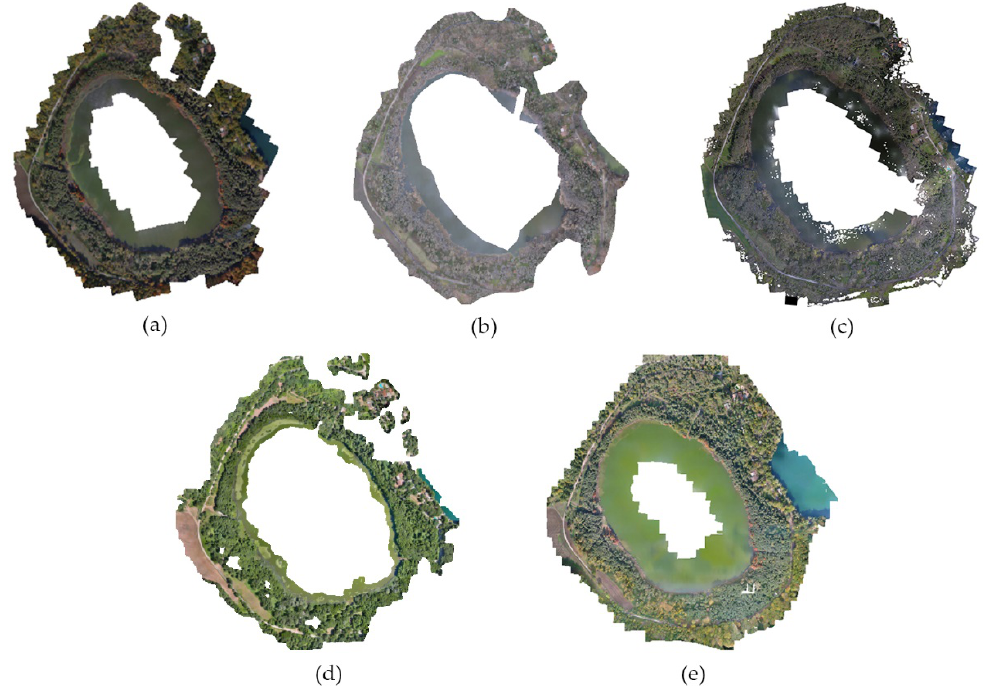
Figure 4. Orthophotos of: ( a ) 16 November 2020; ( b ) 29 January 2021; ( c ) 15 April 2021; ( d ) 6 July 2021; ( e ) 10 November 2021.